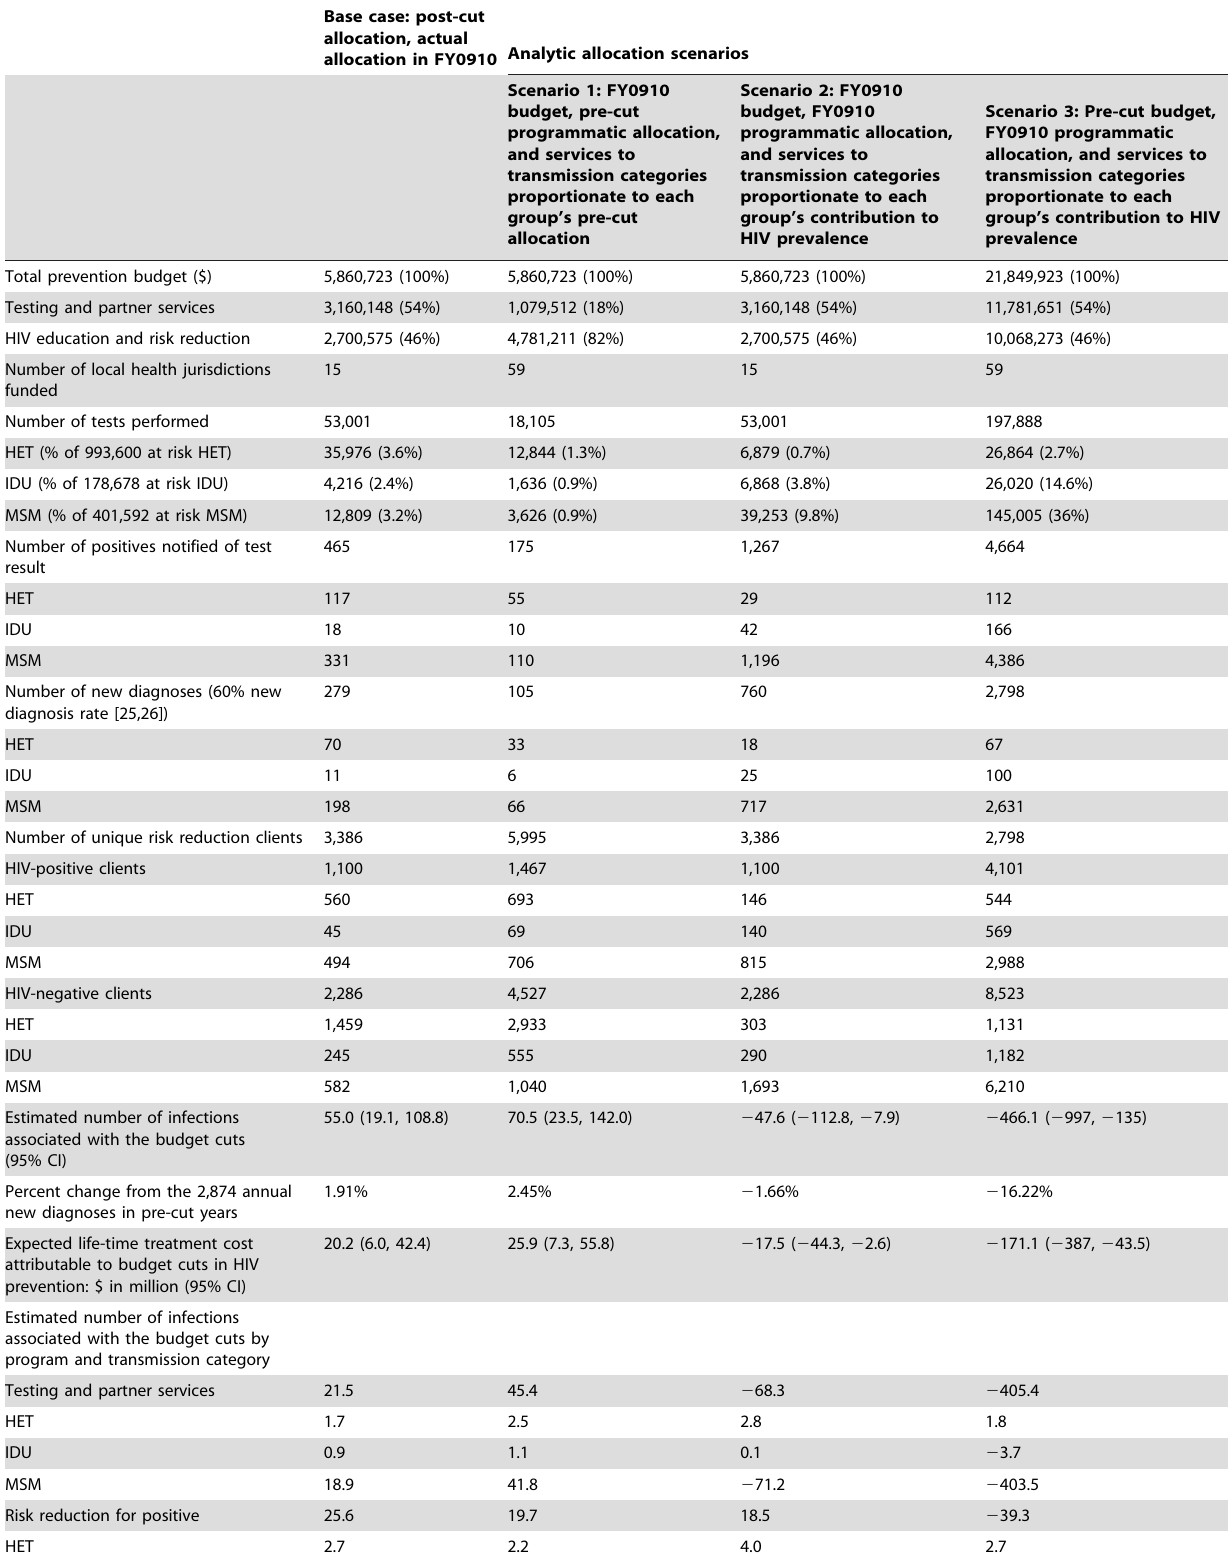
Table 4. Comparison of budget allocations: pre-cut allocation versus actual allocation in